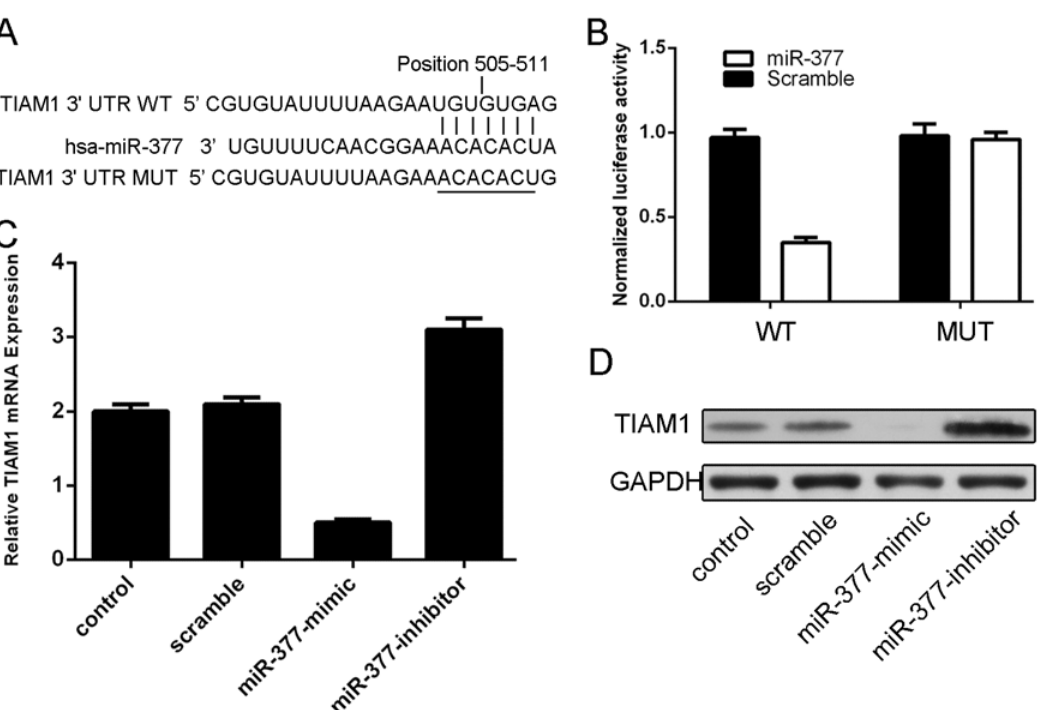
Fig 4. MiR-377 downregulates TIAM1 through interaction with its 3 ’ -untranslated region. (A) Schematic representation of TIAM1 3 ’ UTR was showing the putative miR-377 target site. (B) Relative luciferase activity of the indicated TIAM1 reporter construct in HepG2 cells is shown. Firefly luciferase values were normalized to Renilla luciferase activity and plotted as relative luciferase activity. (C) RT-PCR analysis was performed to examine the effects of miR- 377 on TIAM1 expression in HepG2 cells. Ectopic expression of miR-377 significantly decreased HepG2 transcripts. GAPDH was used as internal control. (D) Western blotting was performed to examine the effects of miR-377 on the expression of TIAM1. GAPDH was also detected as a loading control.